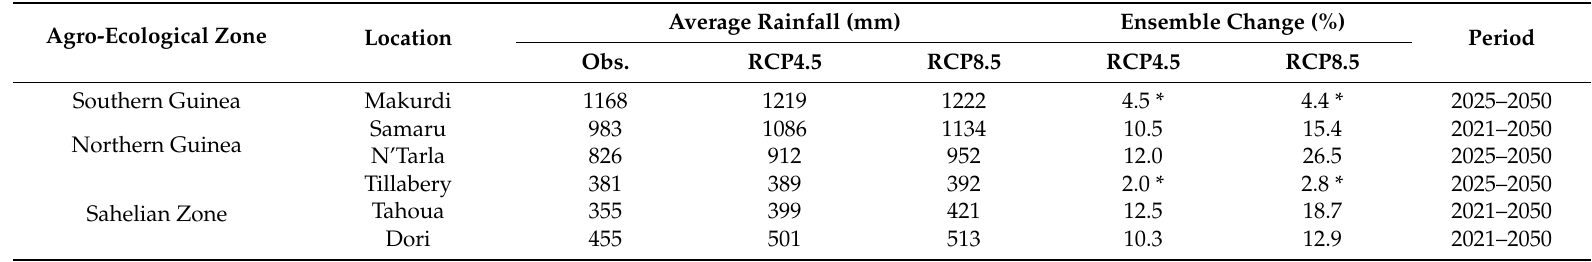
Note, all are statistically significant at 0.05 except * using t -test for mean. Table 4. The summary statistics of the intra-season rainfall characteristic in the Niger River Basin for the future period (2021/2025–2050) relative to the historical period (1976/1980–2005). Note, + or – show the direction of change (increase or decrease) for RCP4.5 for the significant events ( p < 0.05), using t -test for